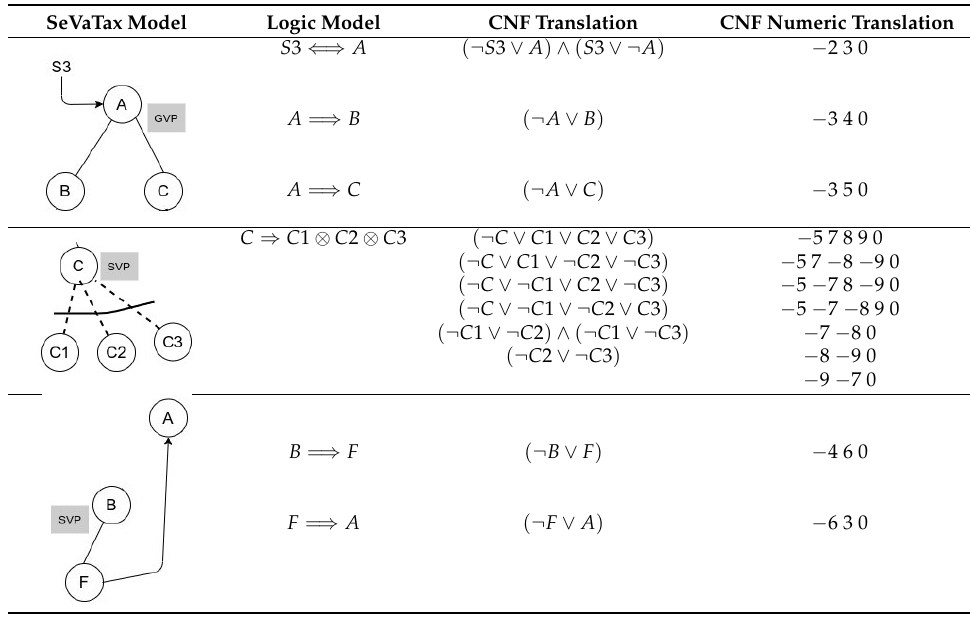
Table 3. Translation of parts of SeVaTax models.